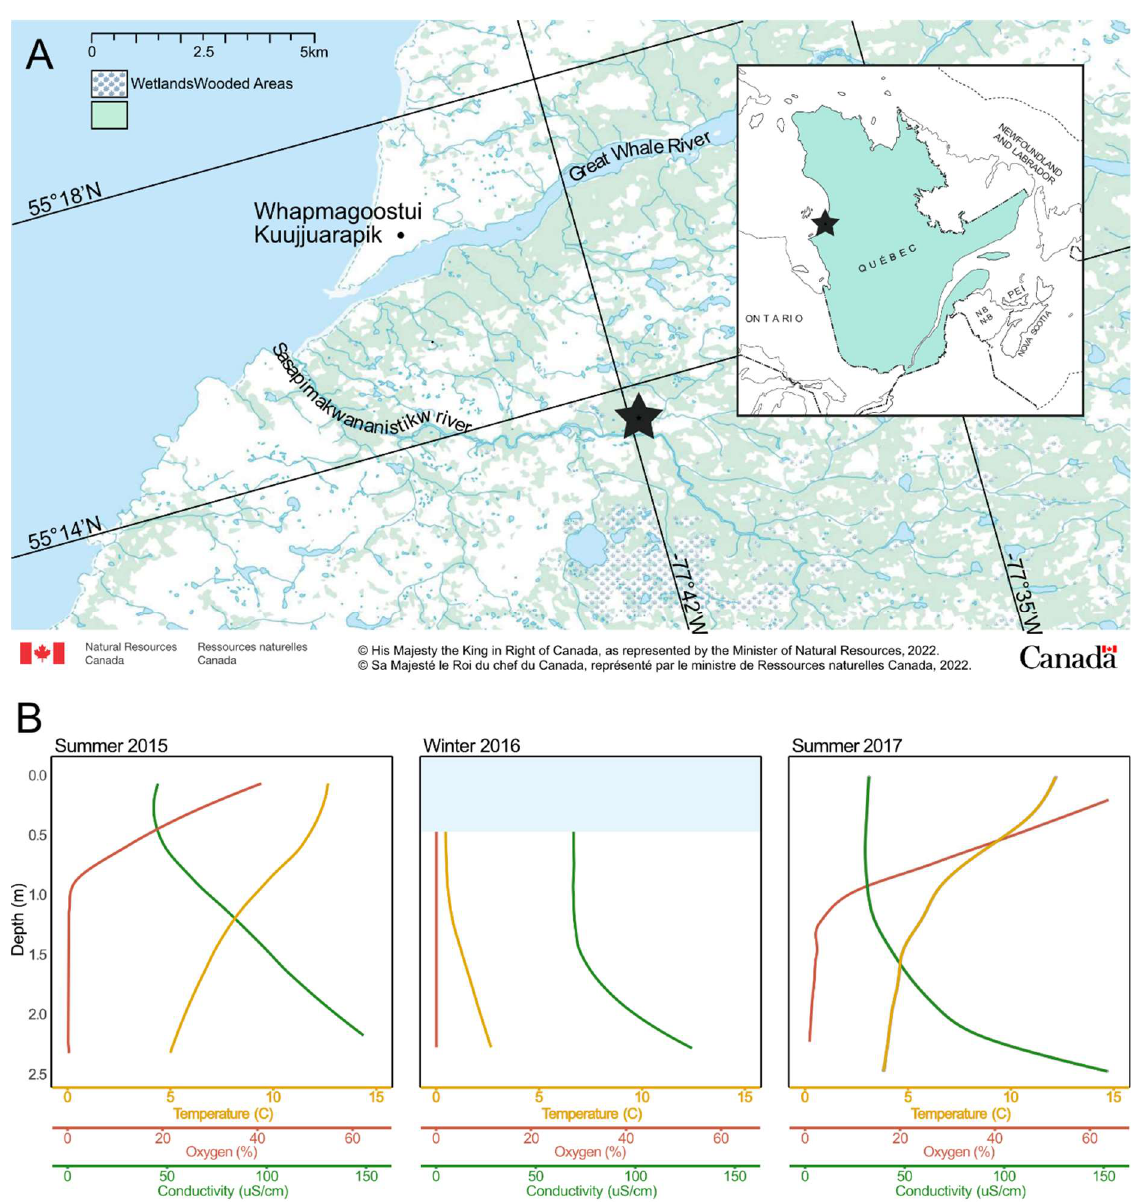
Figure 1. ( A ) Map of the study region, including the SAS valley, indicated by a star. The map was made with tools provided by the Atlas of Canada [38]. ( B ) Profiles for the three sampling dates. The light blue bar in the Winter 2016 panel indicates the presence of ice.